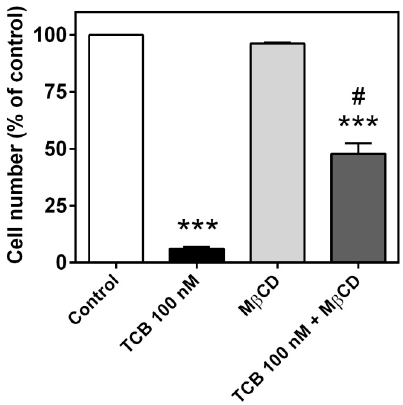
Figure 9. Effect of M β CD on cell proliferation of LLC-PK1 cells treated with telocinobufagin (TCB). Serum-starved LLC-PK1 cells were treated with 100 nM TCB and/or pretreated with 10 mM M β CD for 30 min and then with 1 mM M β CD in 2.5% FBS for 72 h and Trypan blue-free viable cells were counted in Neubauer chamber. Data are the mean ± SEM of three independent experiments in duplicate. *** p < 0.005 vs. control. # p < 0.005 vs. TCB.